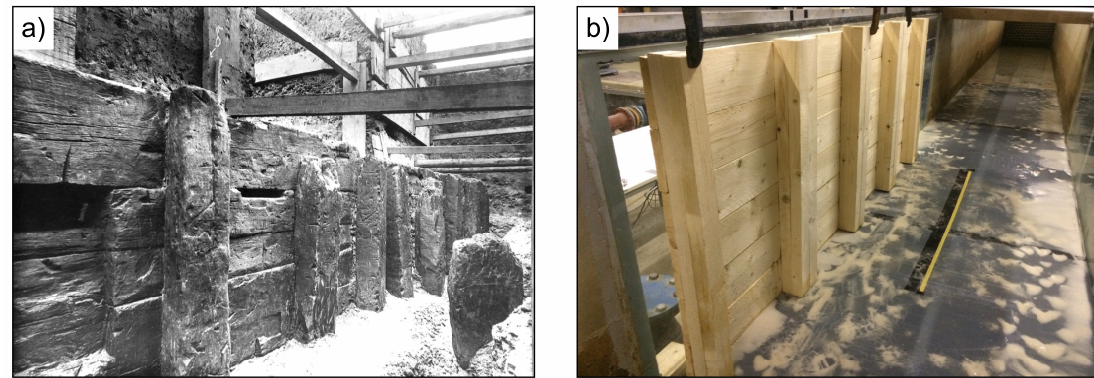
Figure 2. ( a ) Photography of the original harbour structures discovered at the Colonia Ulpia Traiana (CUT) [20] (LVR—Archaeological Park Xanten); ( b ) Scaled physical flume model (PFM) installed in the current flume. View in direction of